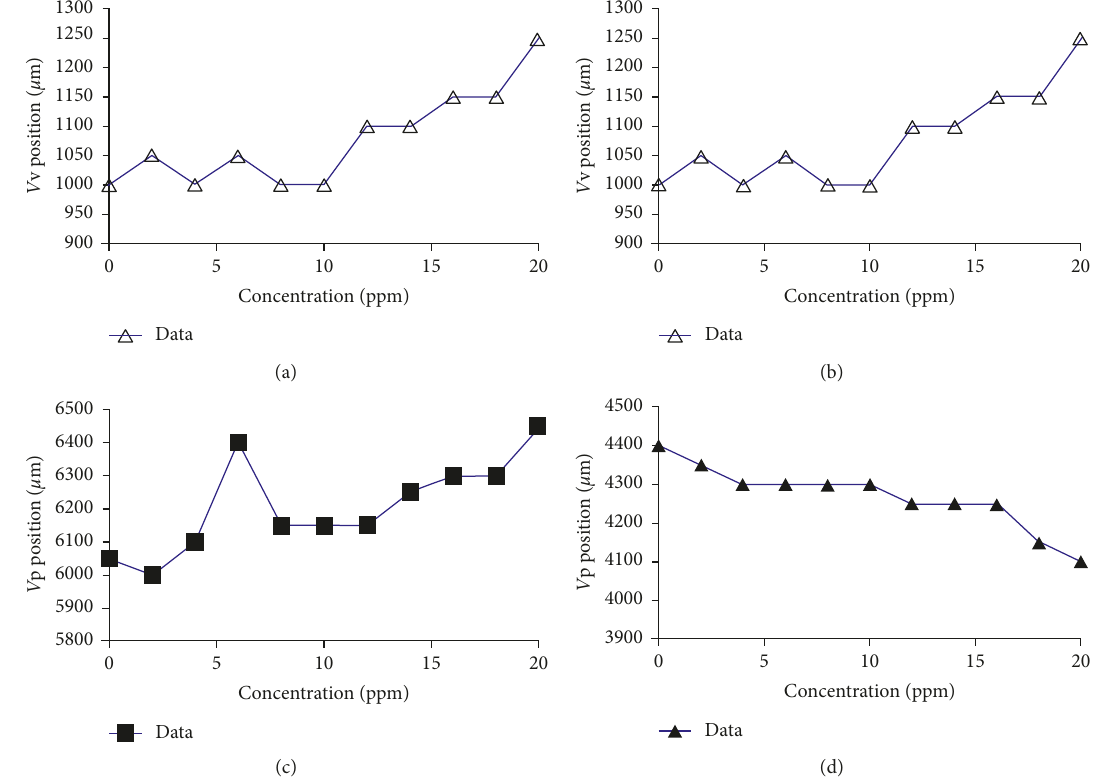
Figure 6: Graph of the relation between rhodamine B concentration and position of V v for (a) concentric and (b) a pair bundle probe. Also, relation between rhodamine B concentration and position of V p for (c) concentric use and (d) a pair bundle